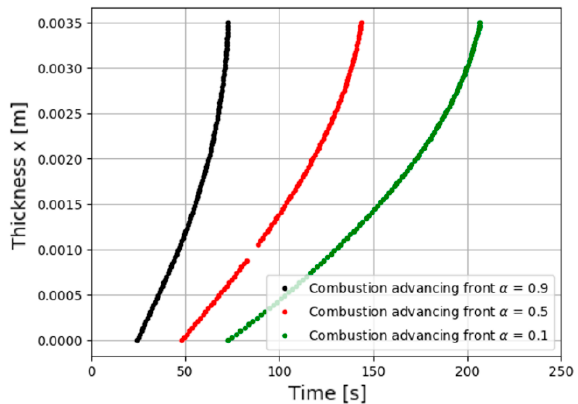
Figure 8. Numerical simulation to predict the combustion advancing front for different degradation rates for an E-glass/polyester composite laminate and a heat flux of 50 kW/m 2. J. Compos. Sci. 2019 , 3 , x